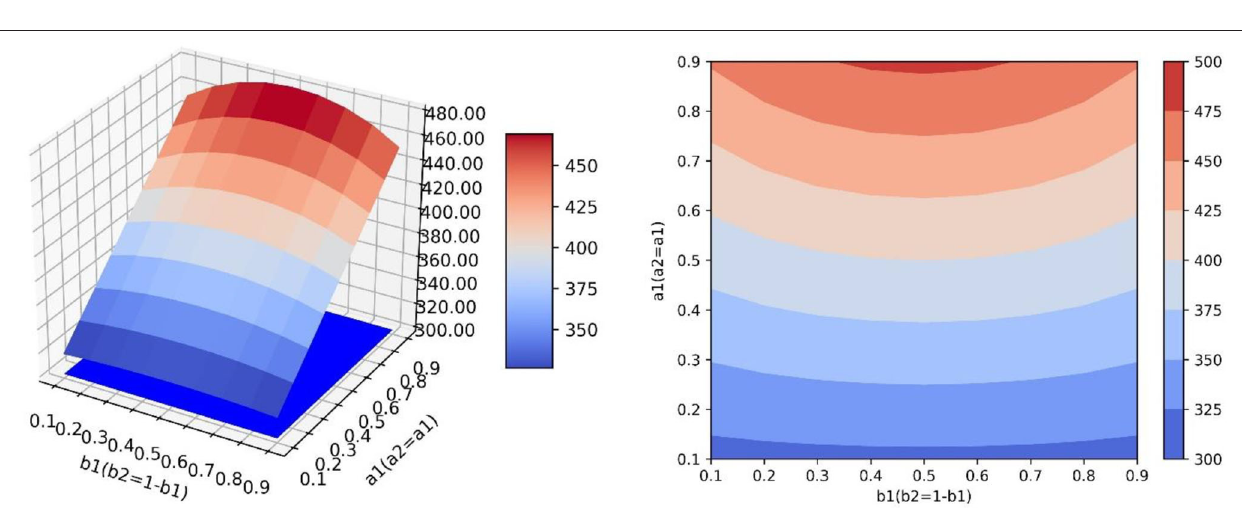
( Figure 12 ): point P 0 represents the guidance effect under the current guidance strategy, at this point, the quantity of positive emotional information y = y P b < 0 >